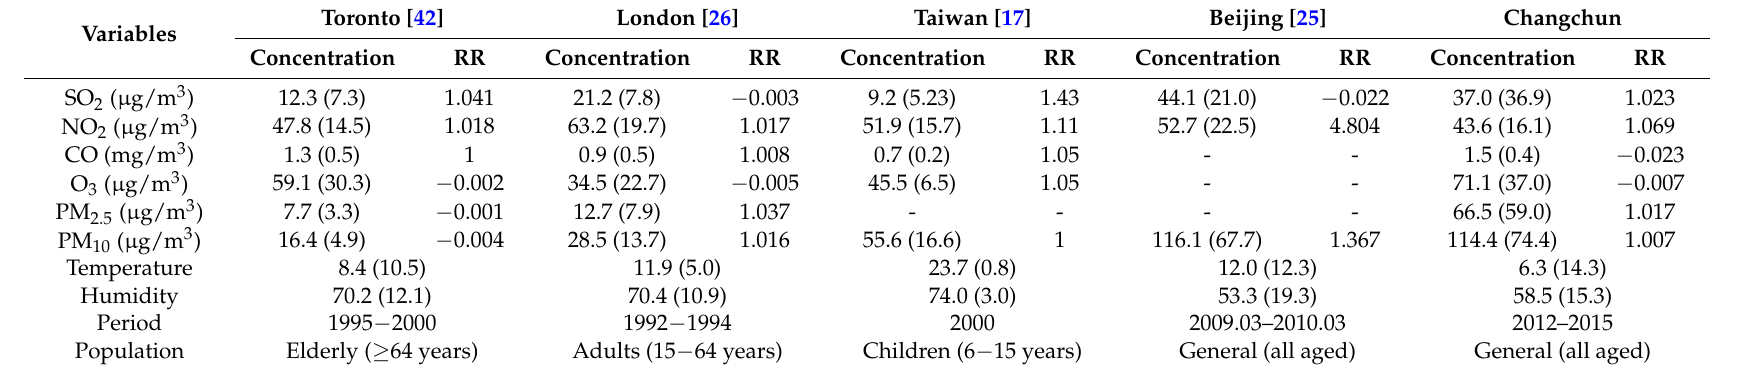
Table 5. RR in the number of outpatients for AR with a 10 µ g/m 3 increase in pollutants for lag